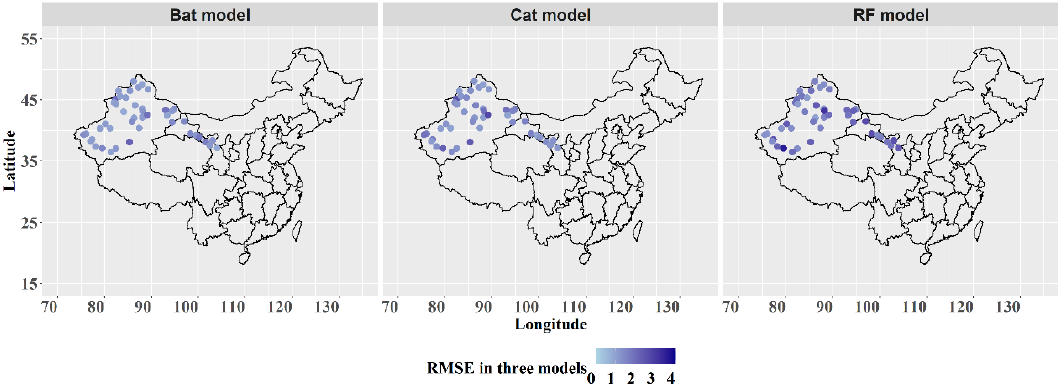
Figure 7. Spatial distribution of the RMSE during testing stage generated from the three models for pan evaporation forecasting.